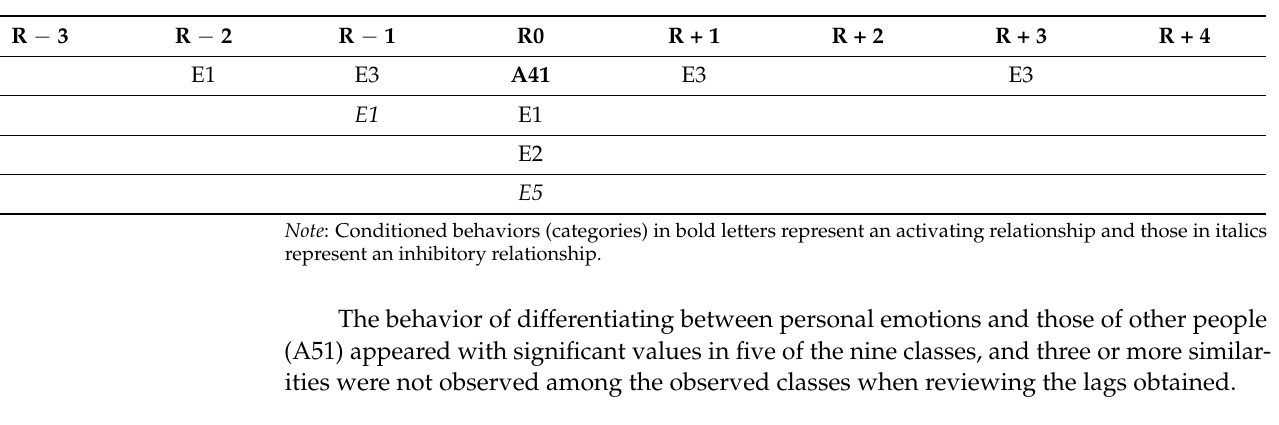
Table 6. Conditioned behaviors associated with the behavior of relating other people’s behaviors to their emotions (A41).